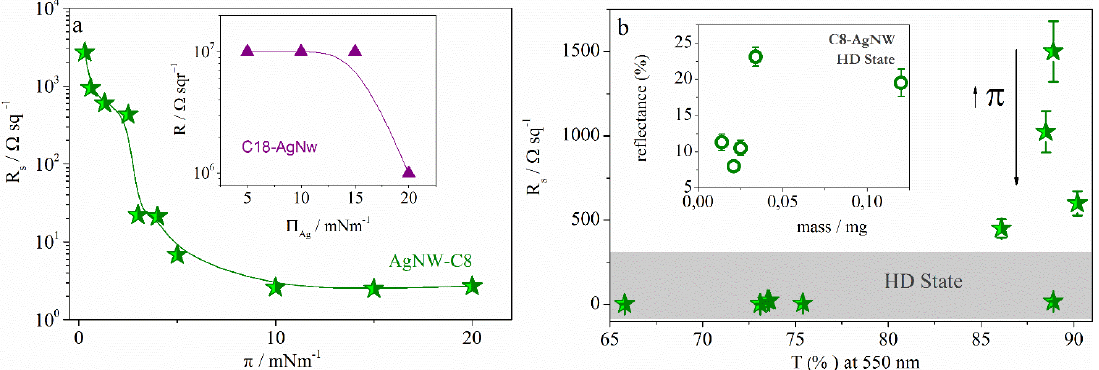
Figure 5. Variation of R s with ( a ) the surface pressure and ( b ) the transmittance for electrodes manufactured with C8 ‐ AgNWs (stars). The inset in figure ( a ) represents the variation of R s with the surface pressure for C18 ‐ AgNWs (triangles). Inset in ( b ) represents the variation of the reflectance with the C8 ‐ AgNWs mass (circles). High Surface Density (HD).